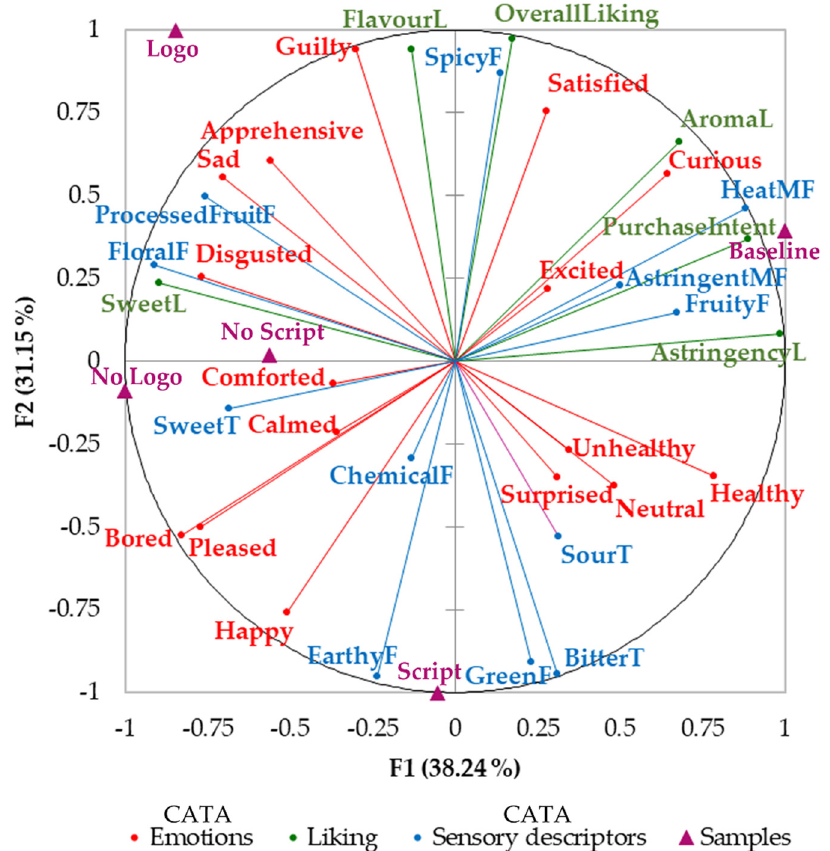
Figure 5. Multiple factor analysis of the check all that apply (CATA) tests for emotions and sensory descriptors and self-reported liking responses. Abbreviations: F: flavor, MF: mouthfeel; L: liking; T: taste.